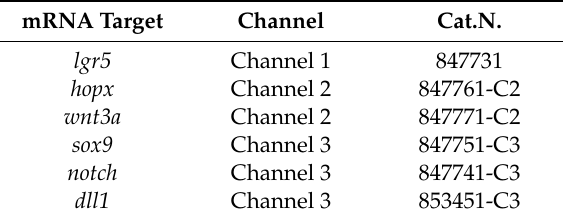
Table 1. Probe targets and corresponding conjugated